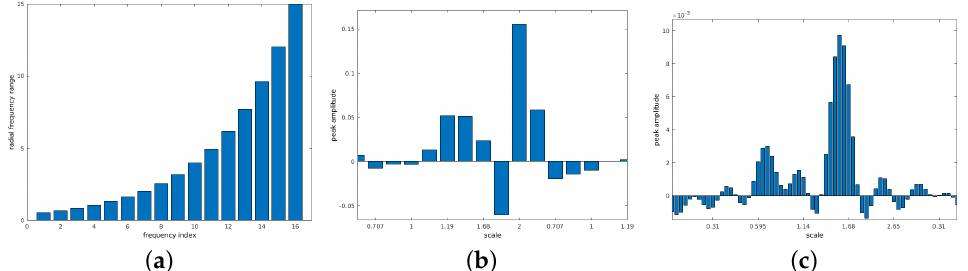
Figure 4. Limited radial resampling function for the determination of scale parameter. A clear peak from phase matching of the Mellin descriptor functions is visible despite the very limited signal information. ( a ) Logarithmic resampling function of the restricted frequency range (radial range—m). ( b ) Scale registration peak—according to the resolution shown in ( a ). ( c ) Scale registration peak—oversampling factor